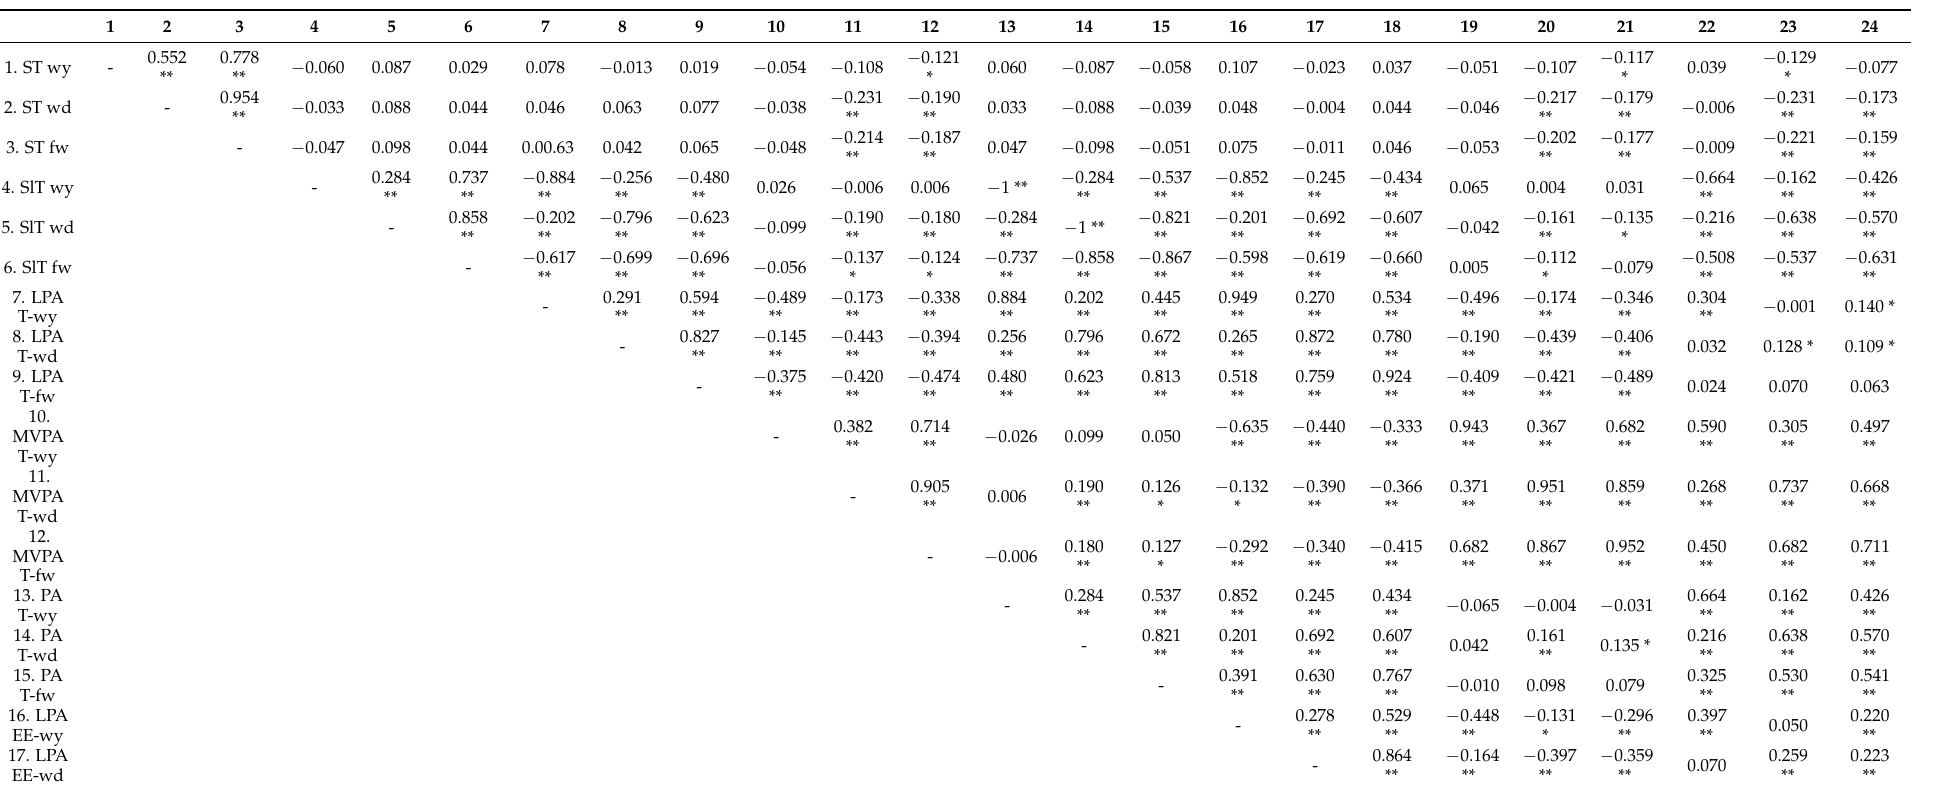
Table 4. Bivariate correlation between screen time, sleep time and physical activity for